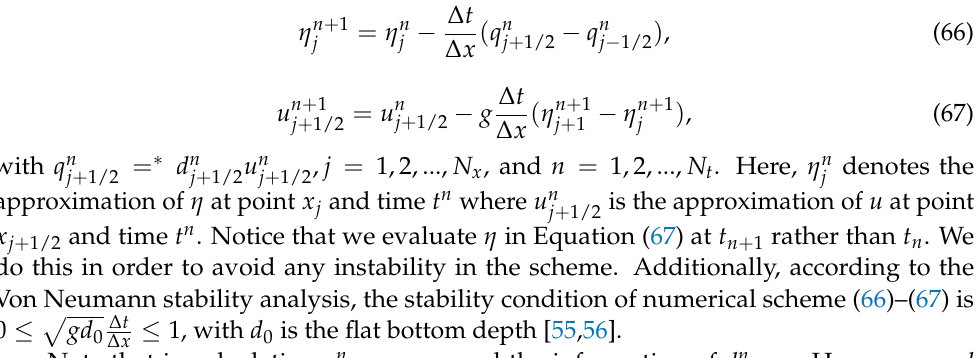
Figure 2. 1-D Staggered Grid